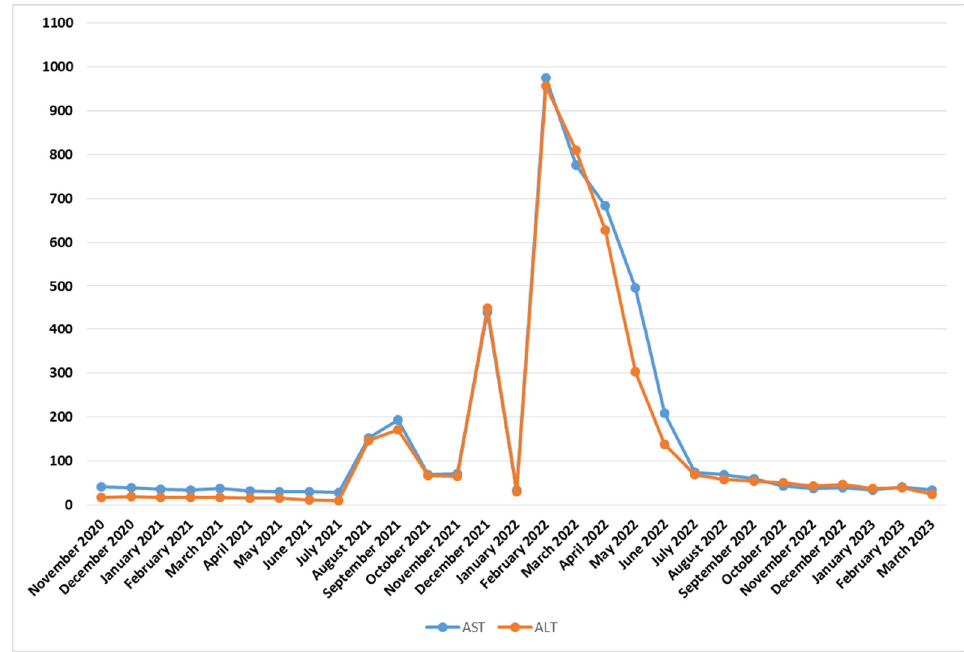
Figure 5. Liver enzyme (AST and ALT) evolution during the treatment.